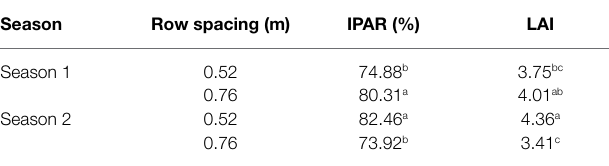
TABLE 2 | Effect of row spacing on IPAR and leaf area index (LAI) at tasseling (VT) across all plant populations in Seasons 1 and 2. Season Row spacing (m) IPAR (%)